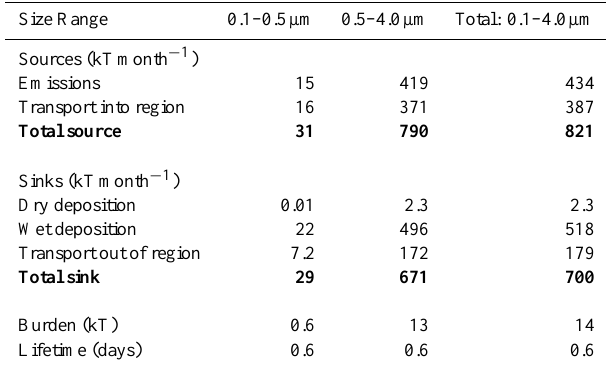
Table 6. GEOS-Chem model sea salt budget over Borneo, 25 June– 25 July, 2008.